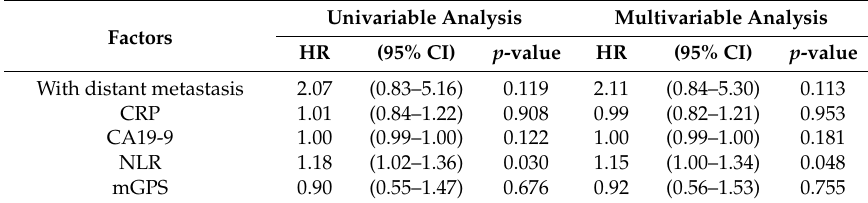
Table 4. Cox proportional hazard analysis of the risk factors associated with overall survival among various adverse events observed in advanced pancreatic cancer patients receiving modified FOLFIRINOX therapy.